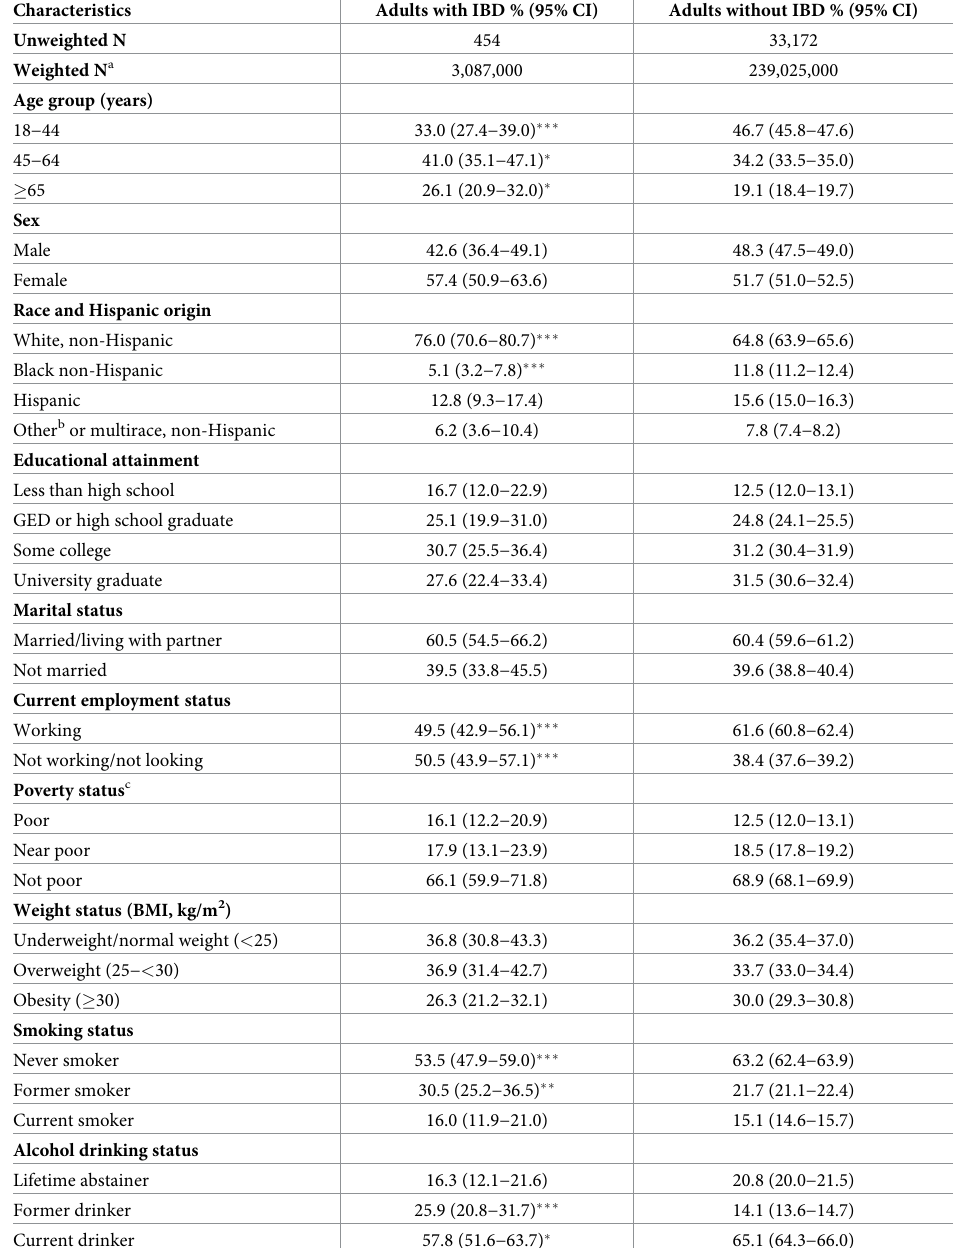
Table 1. Distribution of sociodemographic characteristics and health-related behaviors among adults by inflam- matory bowel disease status, United States,